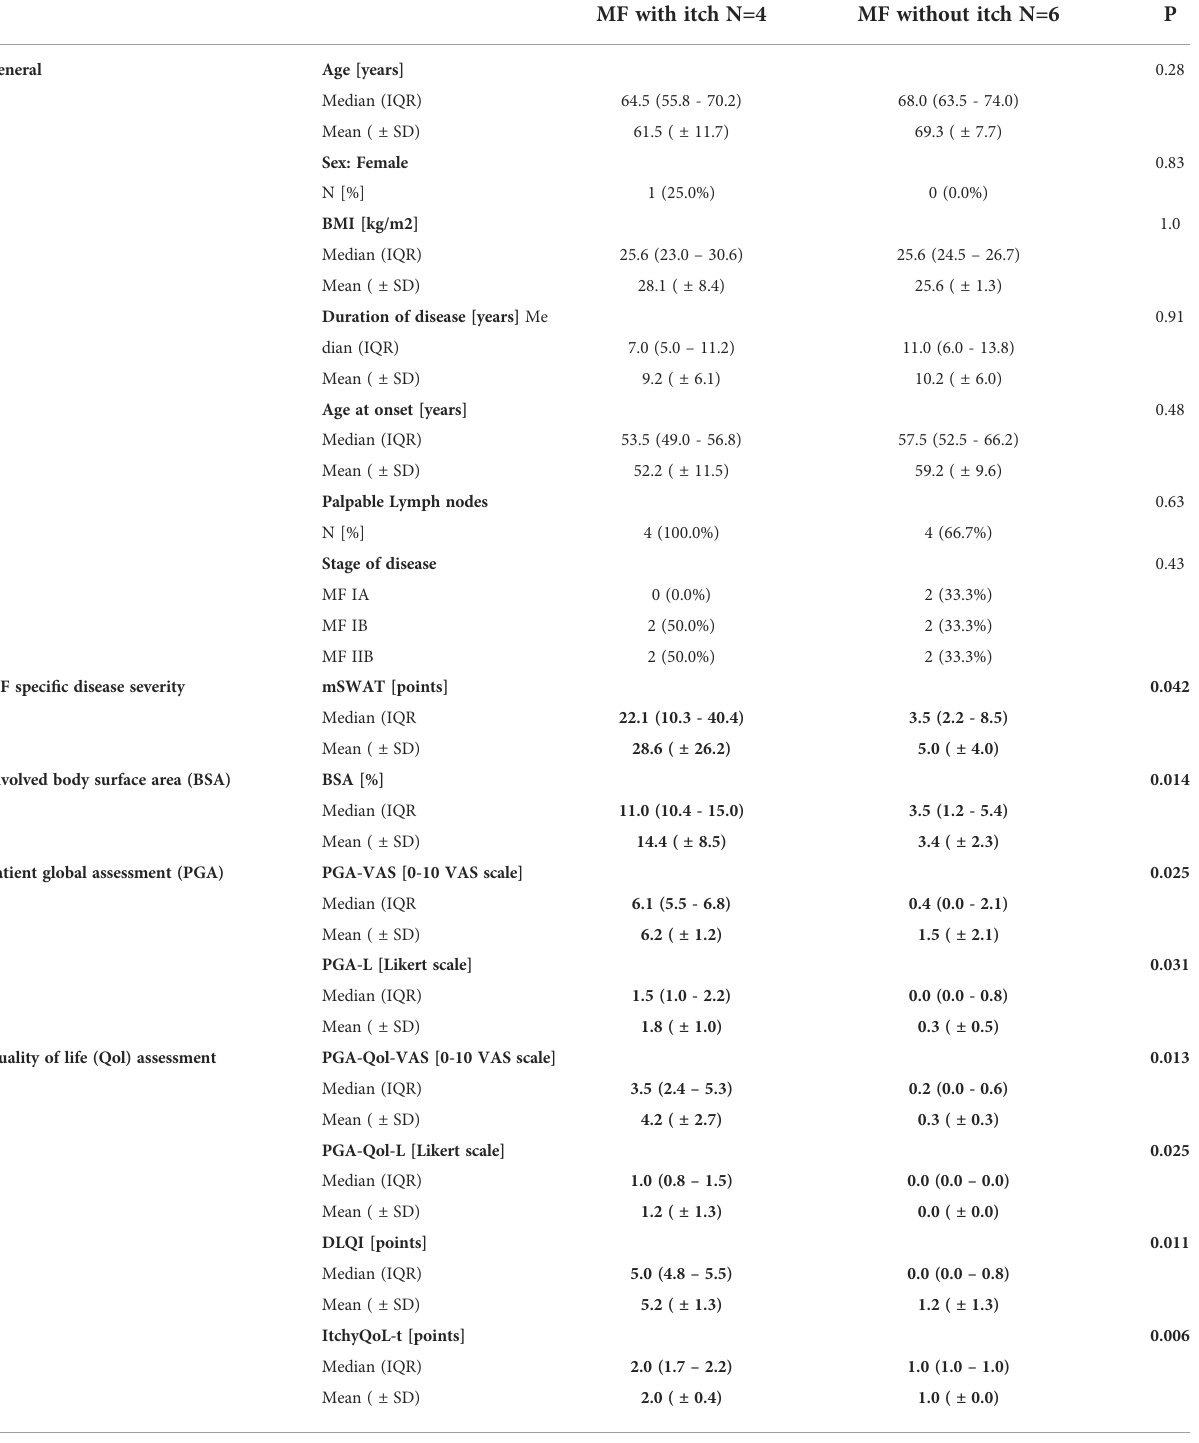
TABLE 2A Clinical characteristics of MF patients with and without